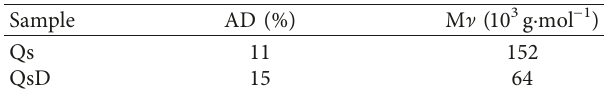
Table 2: Main characteristics of chitosan before and after the enzymatic hydrolysis.